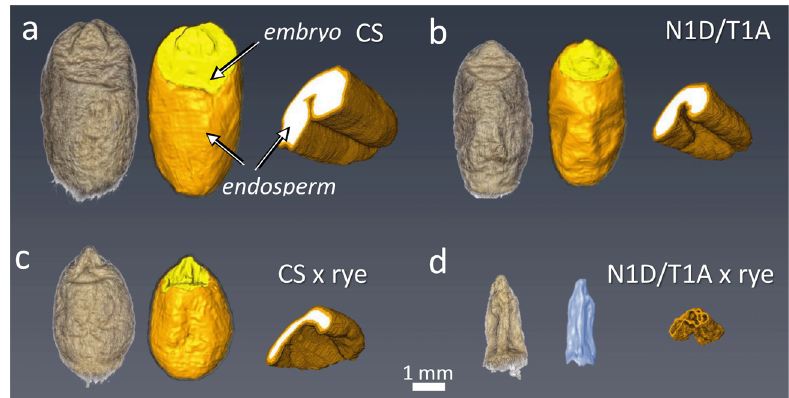
Fig. 3 Structure of intact mature grains as revealed by comparative 3D-MRI analysis. ( a ) CS self-pollination, ( b ) CS N1D/T1A self-pollination; ( c ) CS x rye; ( d ) CS N1D/T1A x rye. From left to right: the image of intact seed, 3D-model of embryo and endosperm; virtual cross-section showing the shape of endosperm (white) or empty space (drawn in blue) inside of the grain. See also Movie